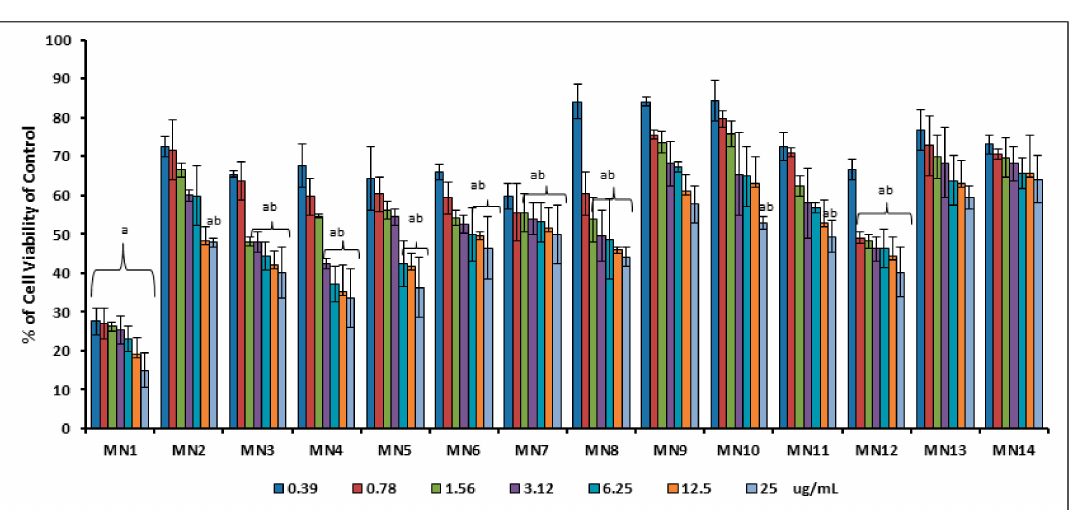
Figure 3. The percentage of cell viability of RIN-5F ranging from 0.39–25 µ g/well in 1 h. Mean ± standard deviation (S.D.), n = 3, small letters represent Dunnet’s test. Mean values that do not share a letter are significantly different ( p < 0.05).